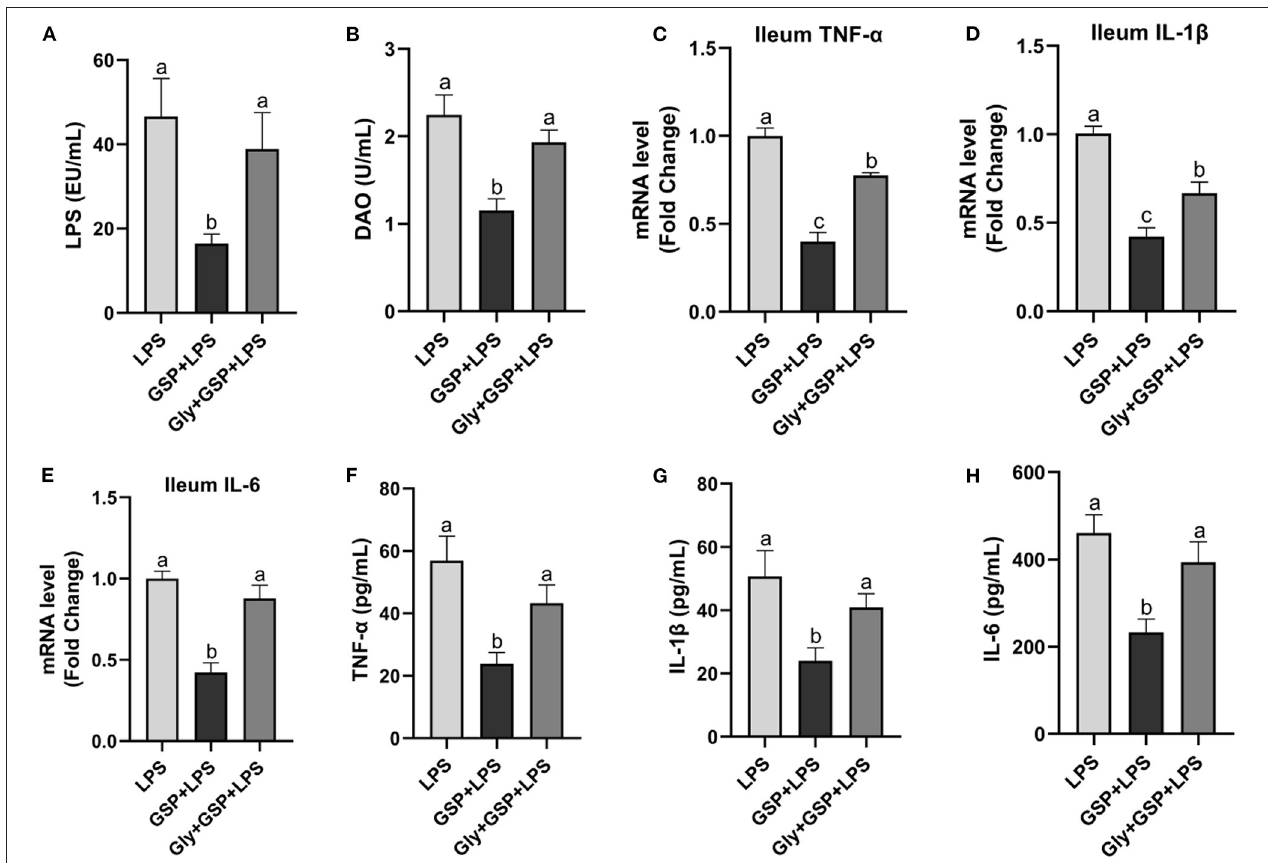
FIGURE 5 | The inflammatory cytokines in serum and the inflammatory cytokine gene expressions in ileum of C57BL/6 mice with different treatments in Experiment 2. (A) Serum lipopolysaccharide (LPS), (B) diamine oxidase (DAO), (C–E) the ileal inflammatory cytokine gene expression of tumor necrosis factor- α (TNF- α ), interleukin-1 β (IL-1 β ) and IL-6, and (F–H) serum TNF- α , IL-1 β and IL-6. LPS, a LPS injection group that oral gavaged with physiological saline before i.p. LPS injection; GSP + LPS, a GSP administration group that oral gavaged with 250 mg/kg GSP before i.p. LPS injection; Gly + GSP + LPS, the GSP + LPS group coupled with a dose of 10 mg/kg BW glycine- β -muricholic acid. Data are presented by the mean ± SEMs ( n = 6). Bars with no letter in common are significantly different, p ≤